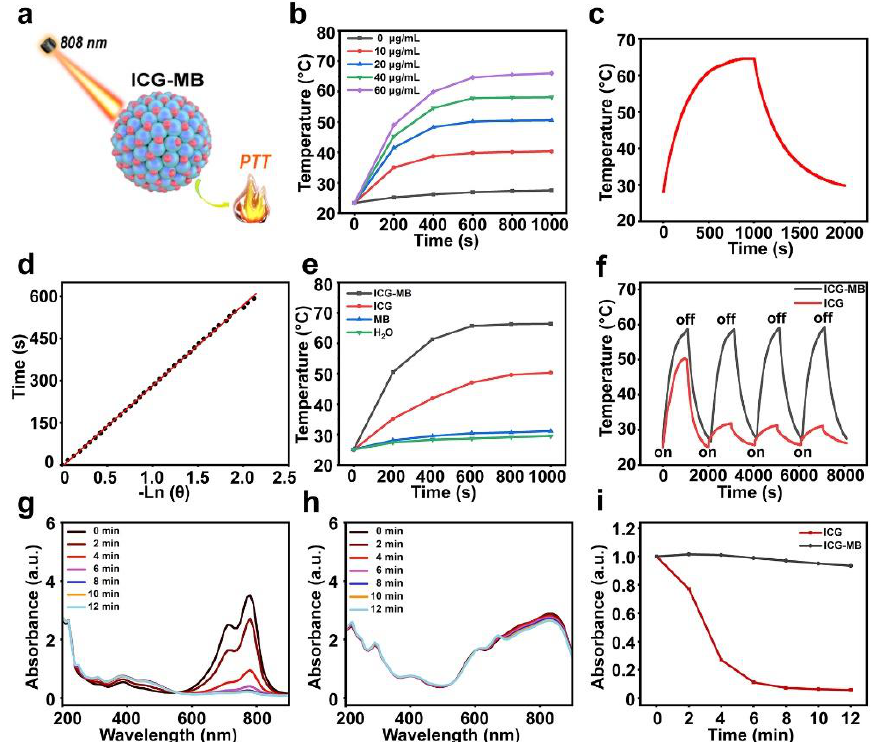
Figure 2. ( a ) Schematic illustration of the PTT behavior of ICG-MB under 808 nm laser irradiation. ( b ) Temperature curve of ICG-MB solution at various concentrations during an 808 nm laser irradiation. ( c ) Photothermal effect of the ICG-MB dispersion under laser irradiation at a wavelength of 808 nm. Irradiation was terminated after 1000 s. ( d ) The time versus the negative natural logarithm of the temperature from the cooling test. ( e ) Temperature curve of ICG-MB, free ICG, free MB and pure water during an 808 nm laser irradiation. ( f ) Heating of the ICG-MB dispersions for four 808 nm irradiation on/off cycles. ( g , h ) UV-vis-NIR absorption spectra of free ICG ( g ) and ICG-MB ( h ) with 808 nm irradiation for different times. ( i ) Normalized absorbance of ICG-MB and free ICG after irradiation with different